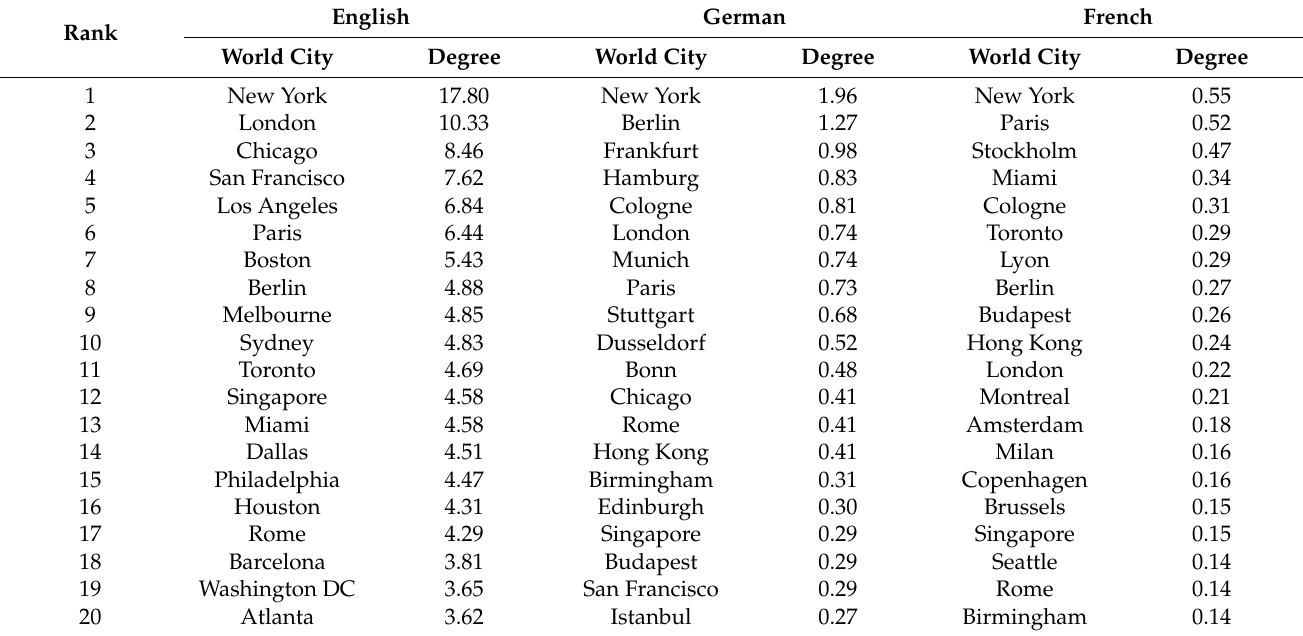
Table 1. World city rankings of the top 20 degree centralities in three